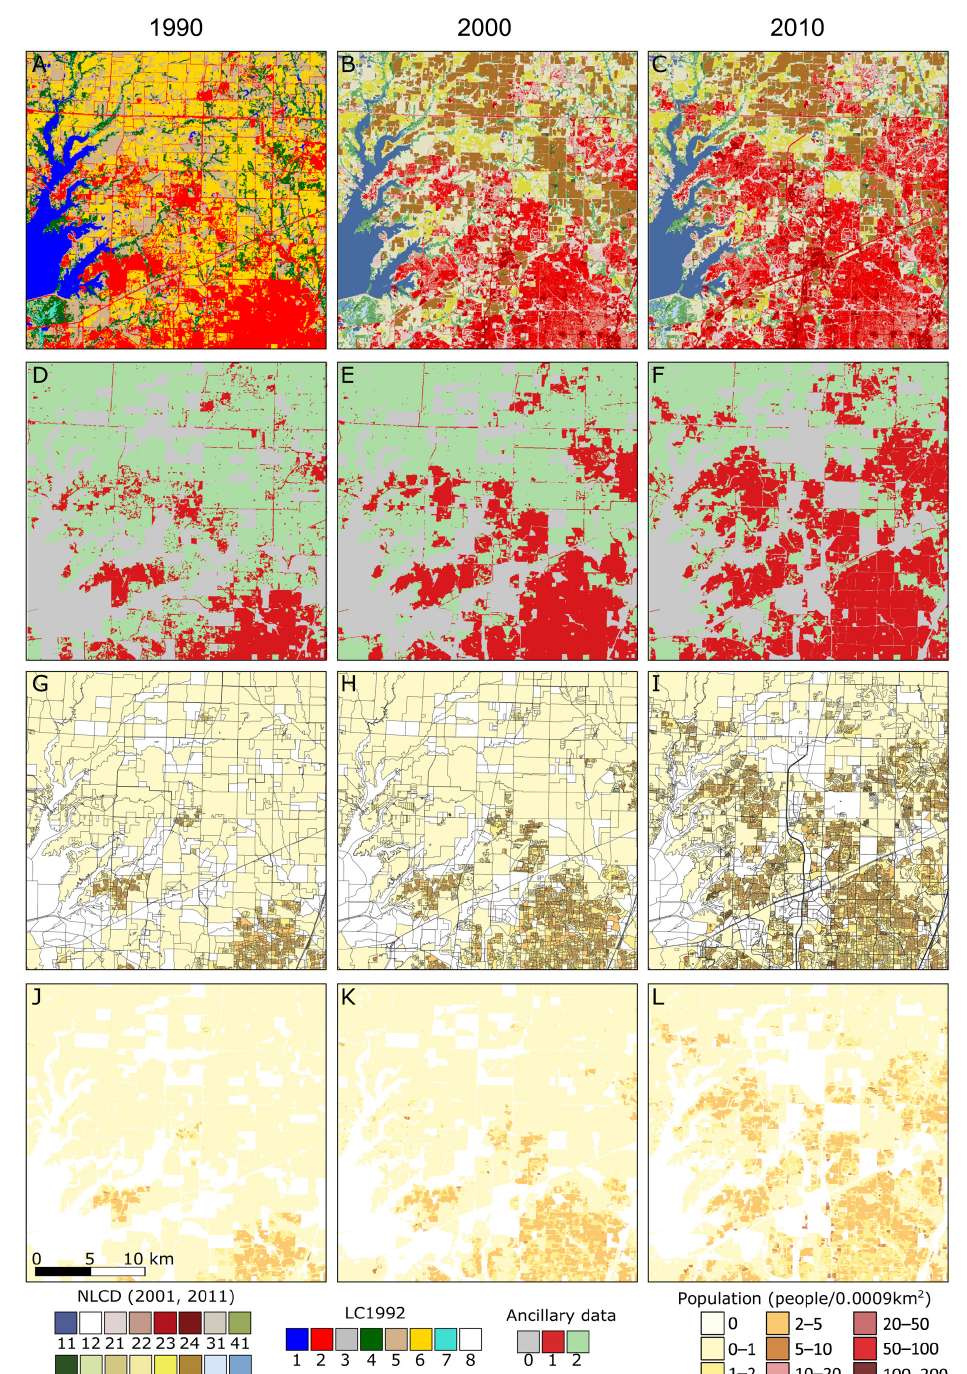
Fig. 3. The city of Frisco, TX located in Collin and Denton